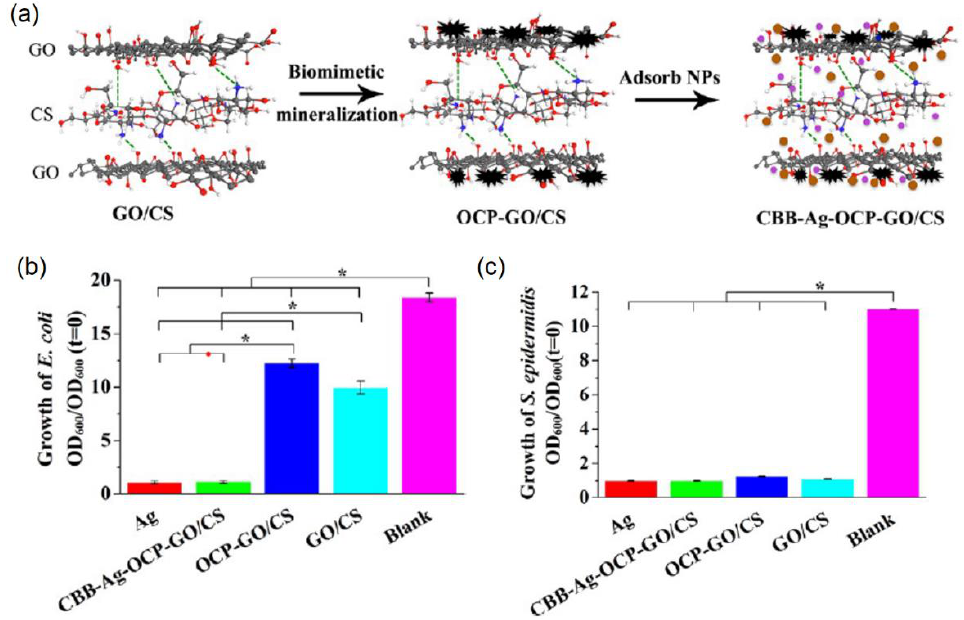
Figure 10. Biomimetic GO-HA nanohybrids for antibacterial application: ( a ) Biomimetic synthesis mechanism; ( b , c ) Antibacterial tests towards ( b ) E. coli and ( c ) S. epidermidis . Reproduced with the permission from [98]. Copyright 2016 American Chemical Society.